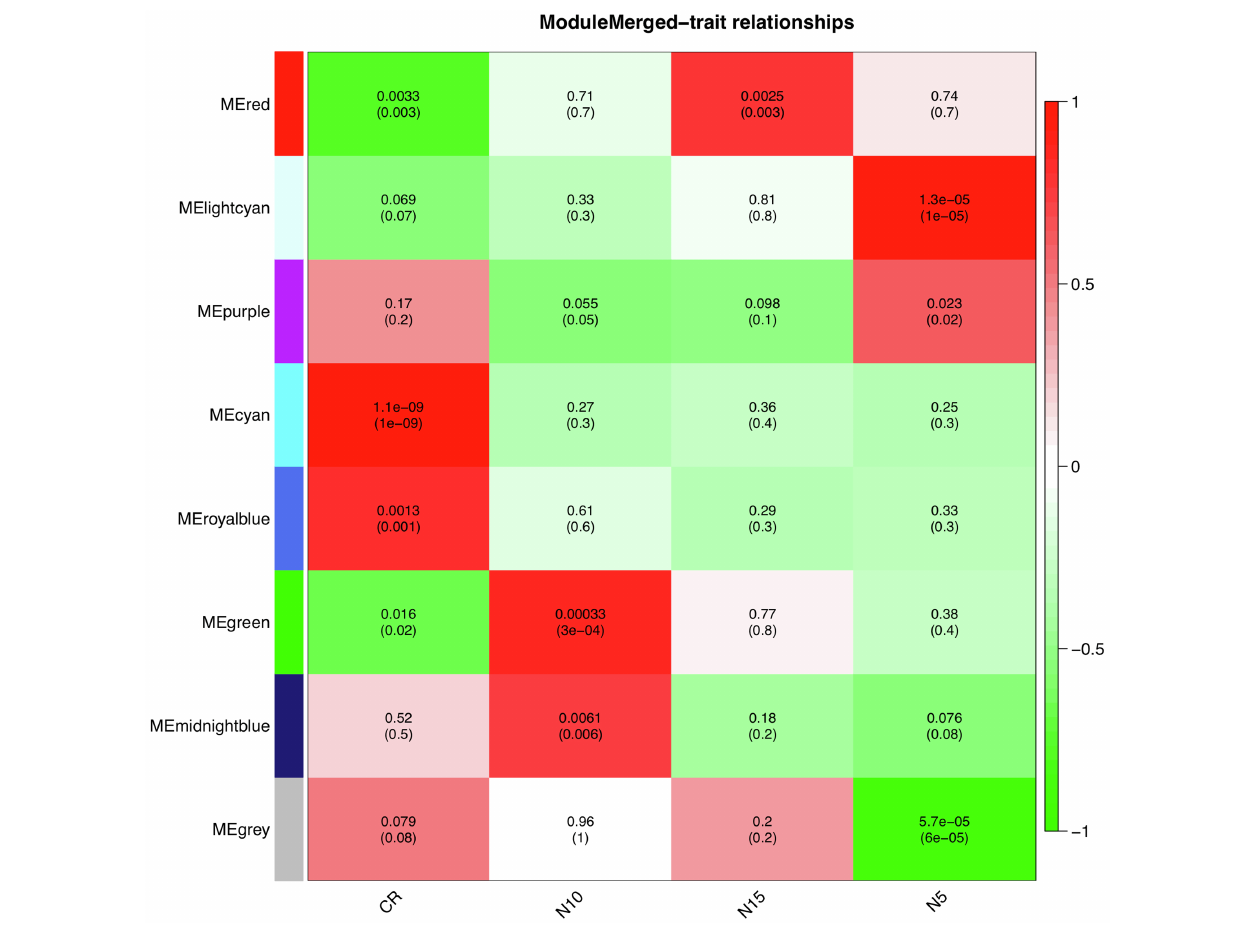
FIGURE 8 | The heatmap of module-traits relationships in SCN data set. The heatmap illustrates correlations between module eigengenes and dpi traits. The numbers represent Pearson’s correlation coefficients and p -values. The color legend represents the strength and direction of